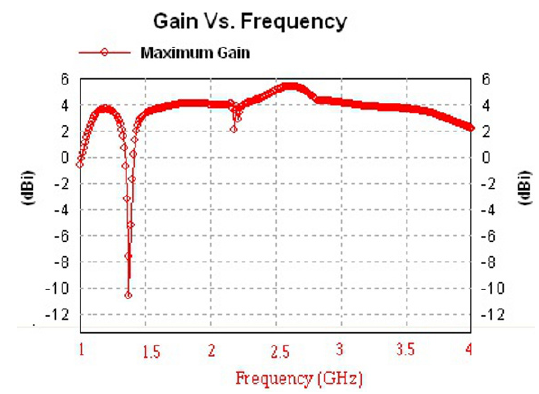
Figure 5. Gain Vs fequency plot of slotted microstrip antenna.